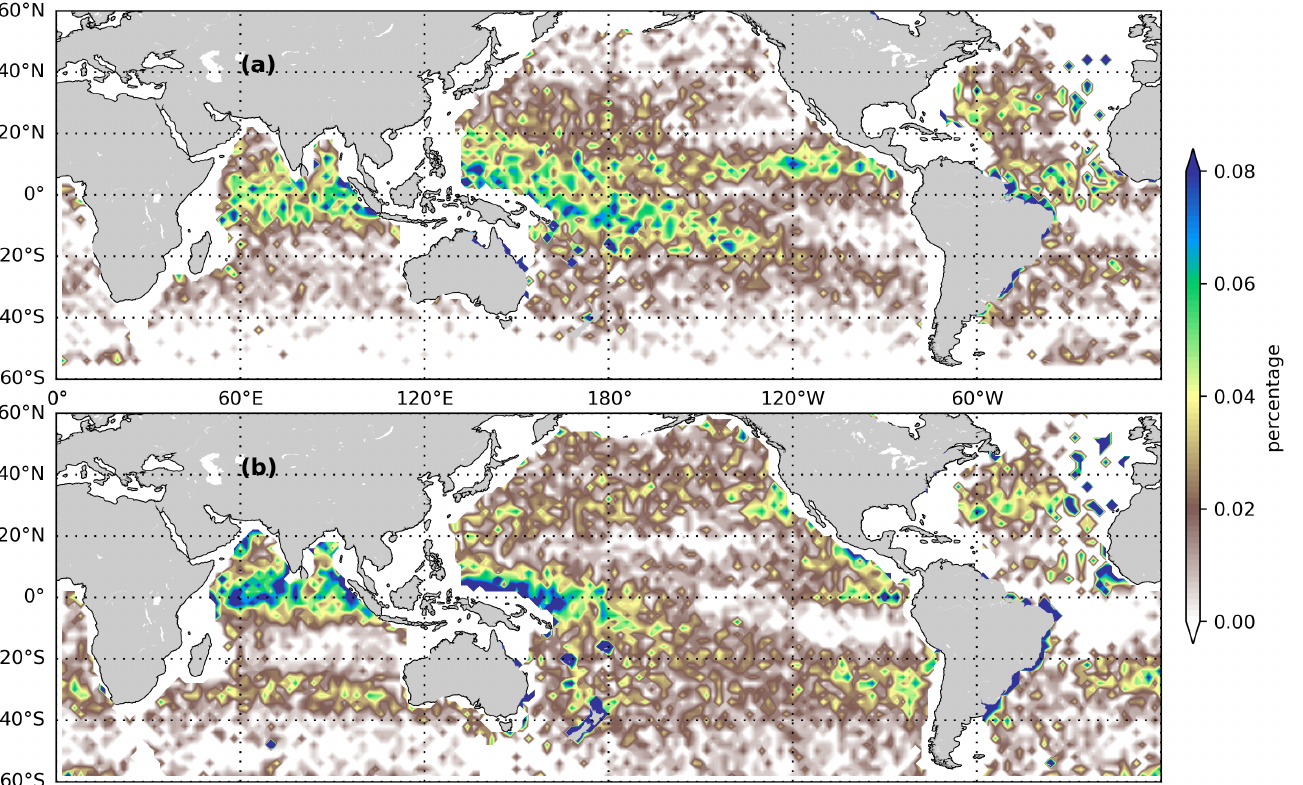
Figure 9. Global percentage map of detected SAR images with ( a ) rain cells and ( b ) low wind area based on the above-defined detection criteria using S-1A WV acquisitions from January 2015 to December